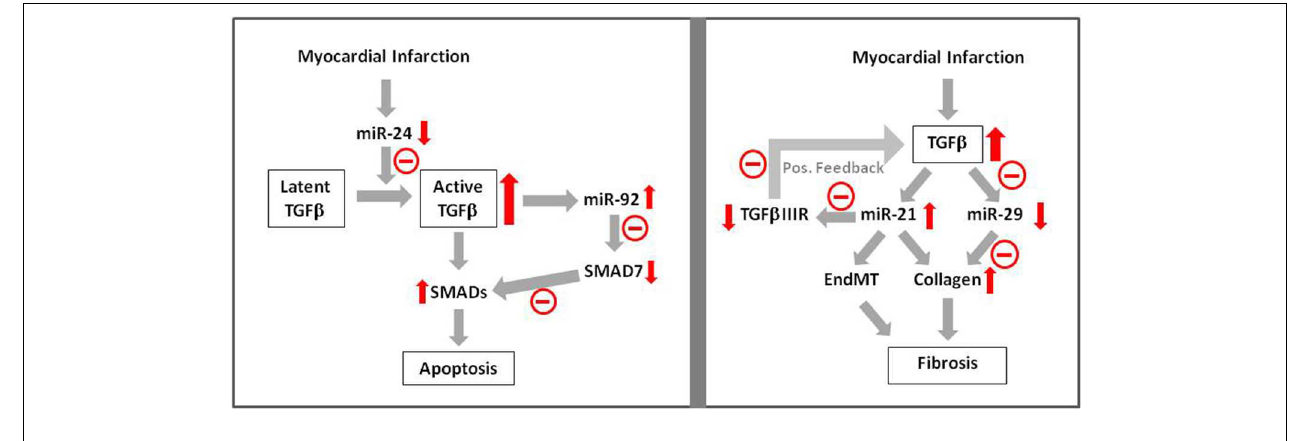
FIGURE 2 | MicroRNA signaling in TGF β -induced apoptosis and fibrosis. Apoptosis induction after myocardial infarction has been shown to be mediated via TGF β —microRNA—SMAD signaling. Influence of microRNAs on fibrosis has been shown via